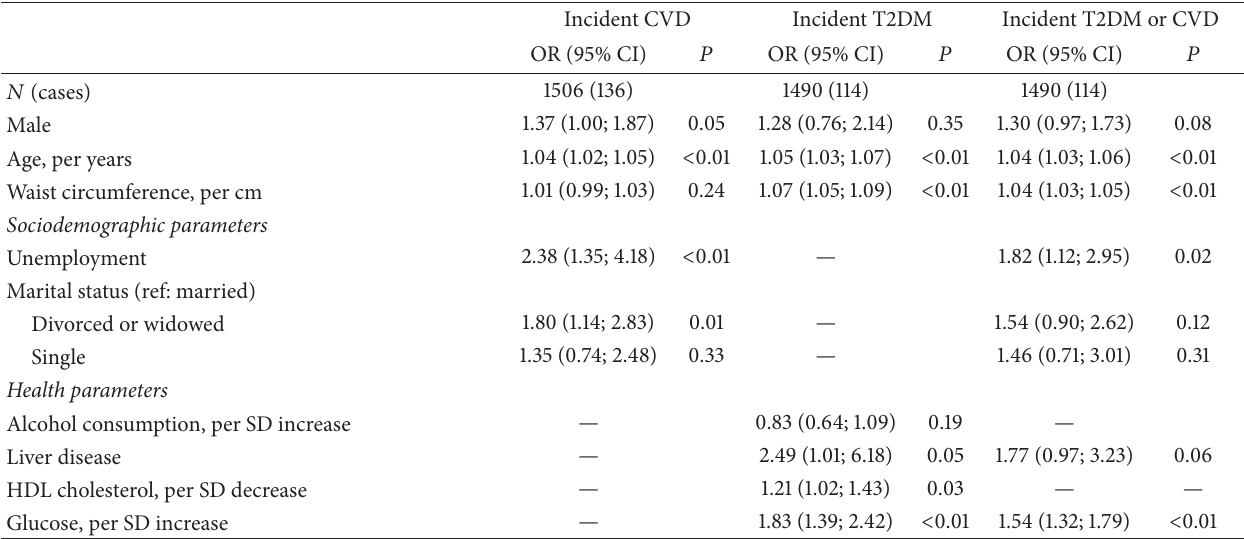
Table 3: Predictors of cardiovascular disease (CVD) or type 2 diabetes mellitus (T2DM) in abdominal obese individuals retained after blockwise selection in multivariate